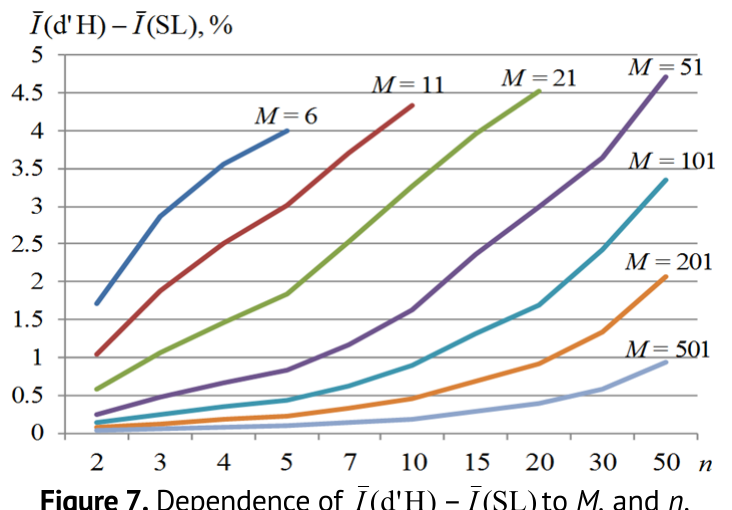
Figure 7. Dependence